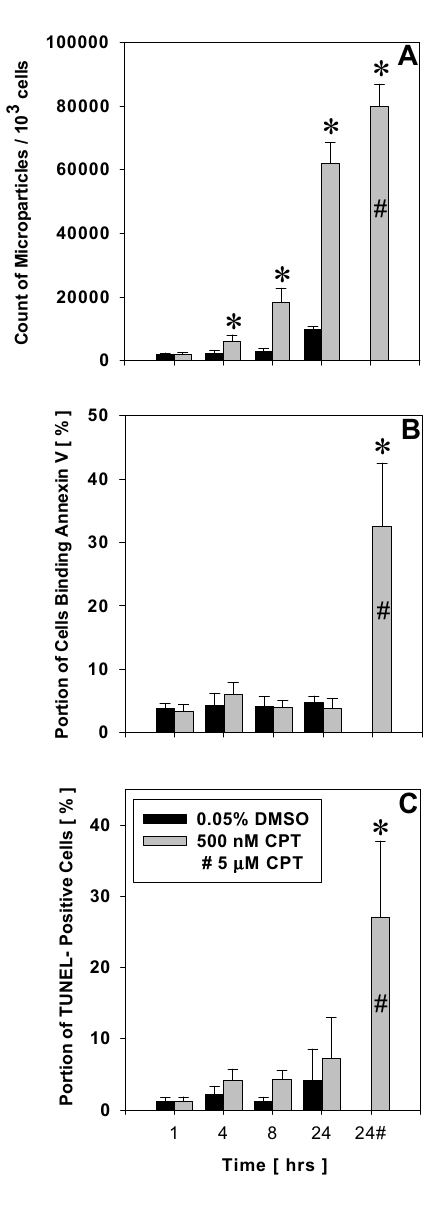
Figure 3 Release of annexin V-binding membrane microparti- cles and the level of cell apoptosis in HUVEC stimu- lated with camptothecin. Confluent HUVEC at 48 hrs in culture were incubated with 0.5 % DMSO or with 500 nM or 5 µ M CPT in medium. After indicated time periods superna- tant from cell culture was harvested and annexin V-FITC- positive MP were counted (A). Adherent cells were har- vested and portions of cells binding annexin V (propidium iodide negative) (B) and portions of TUNEL-positive cells (C) were evaluated. Means of 4 experiments ± SD are presented, * = p < 0.05 vs. DMSO